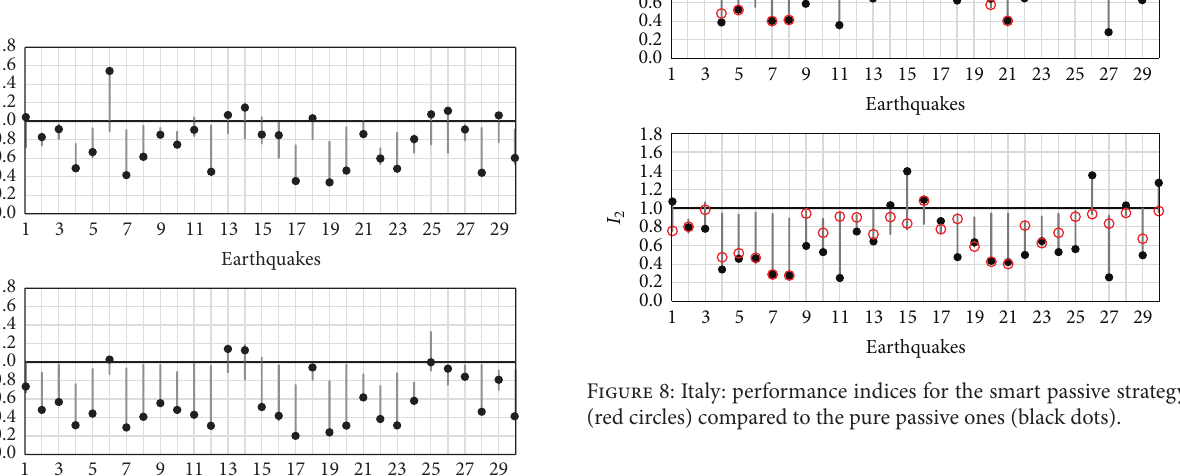
Figure 5: Italy: performance indices for the passive control strate- gies investigated.